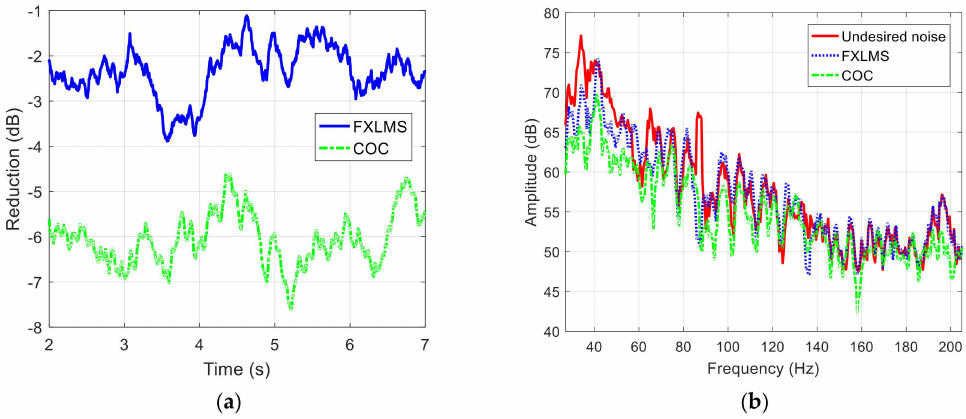
Figure 9. Control results using the data from a car: ( a ) results in time domain and ( b ) results in frequency